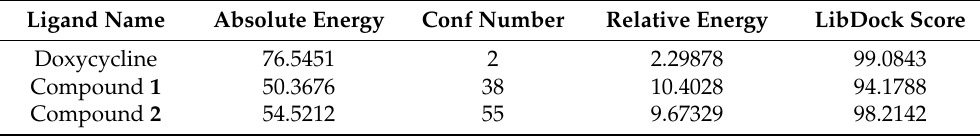
Table 4. The docking parameter table of ligands and the receptor protein 2XRL.